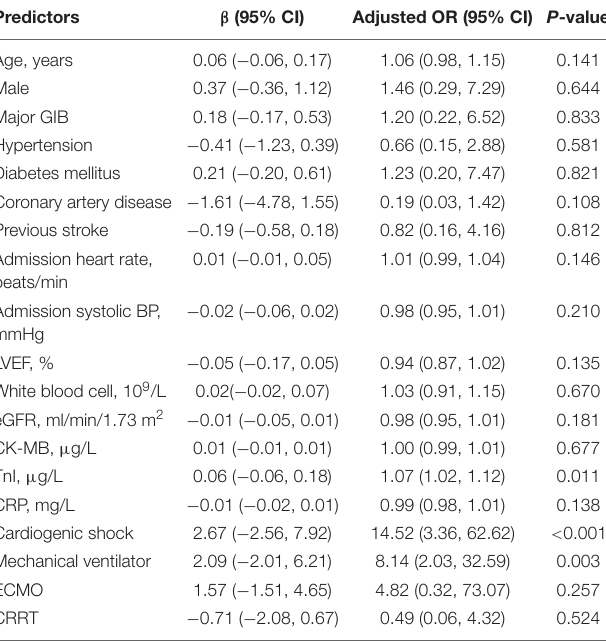
TABLE 3 | The multivariate logistic regression of in-hospital mortality with the beta coefficient and the confident interval.